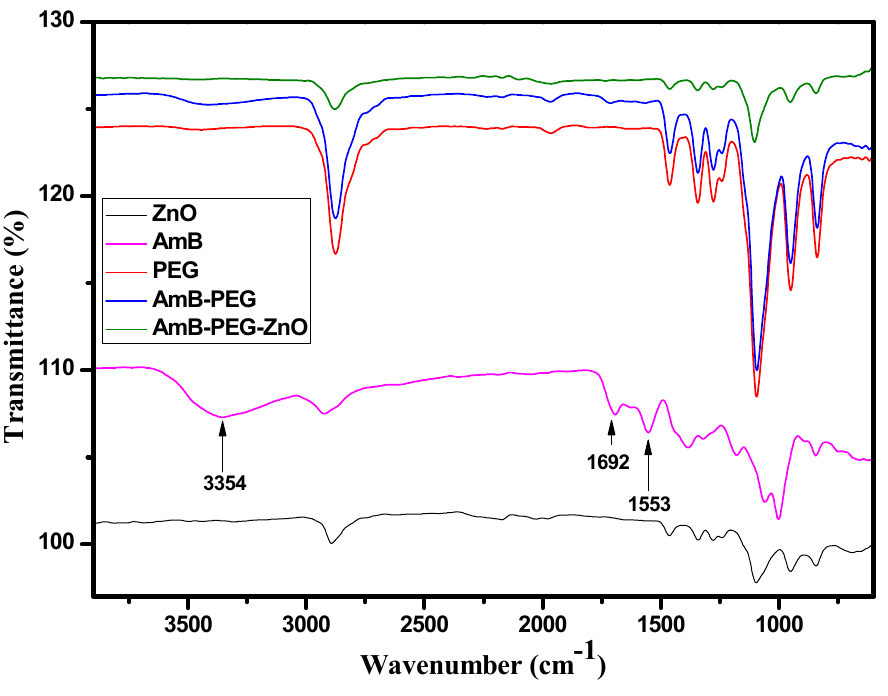
Figure 1. FTIR spectra of ZnO, AMB, PEG, AMB-PEG, and ZnO-AMB-PEG composites.